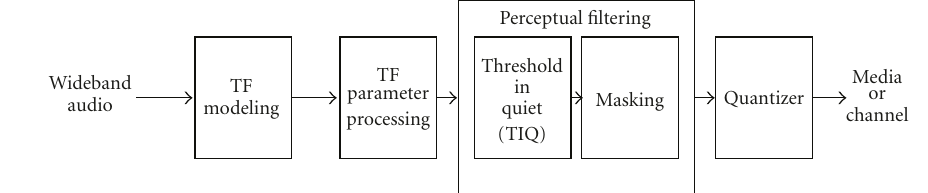
Figure 3: Block diagram of ATFT audio